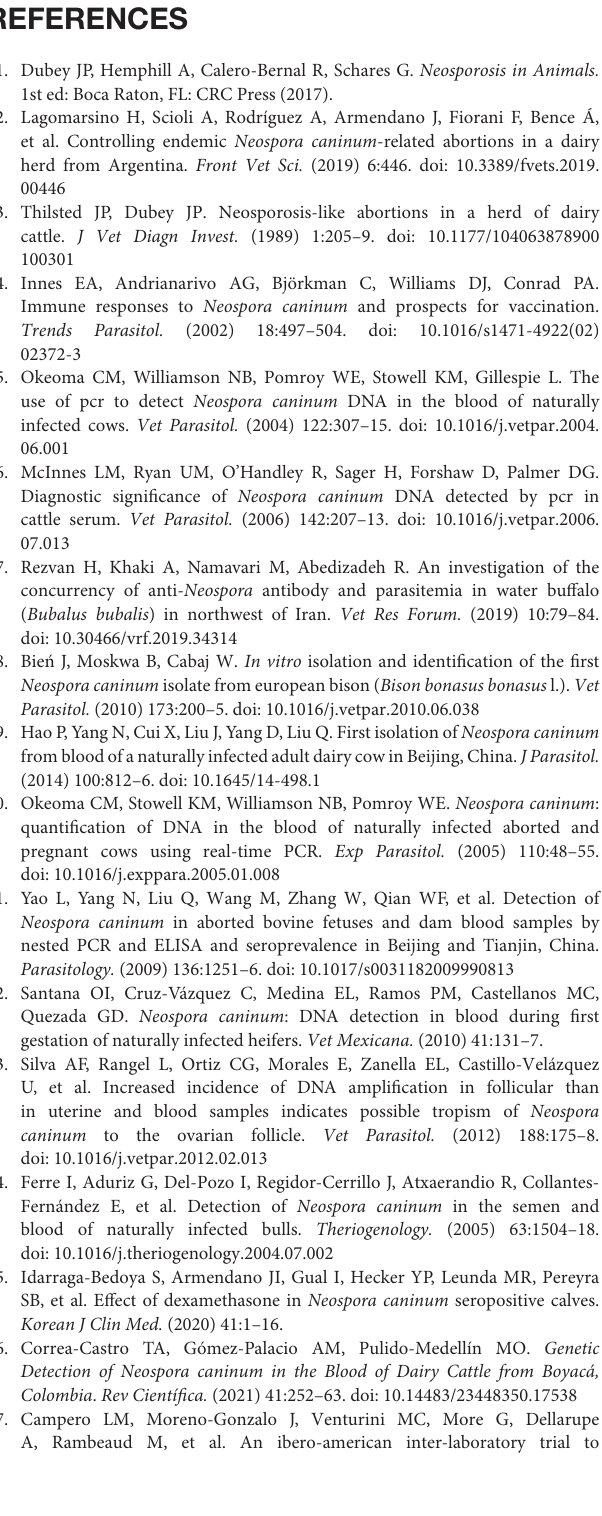
Supplementary Figure 2 | Neospora caninum concentration at different sampling moments for cows from + Preg (A) and + Npreg groups (B) .